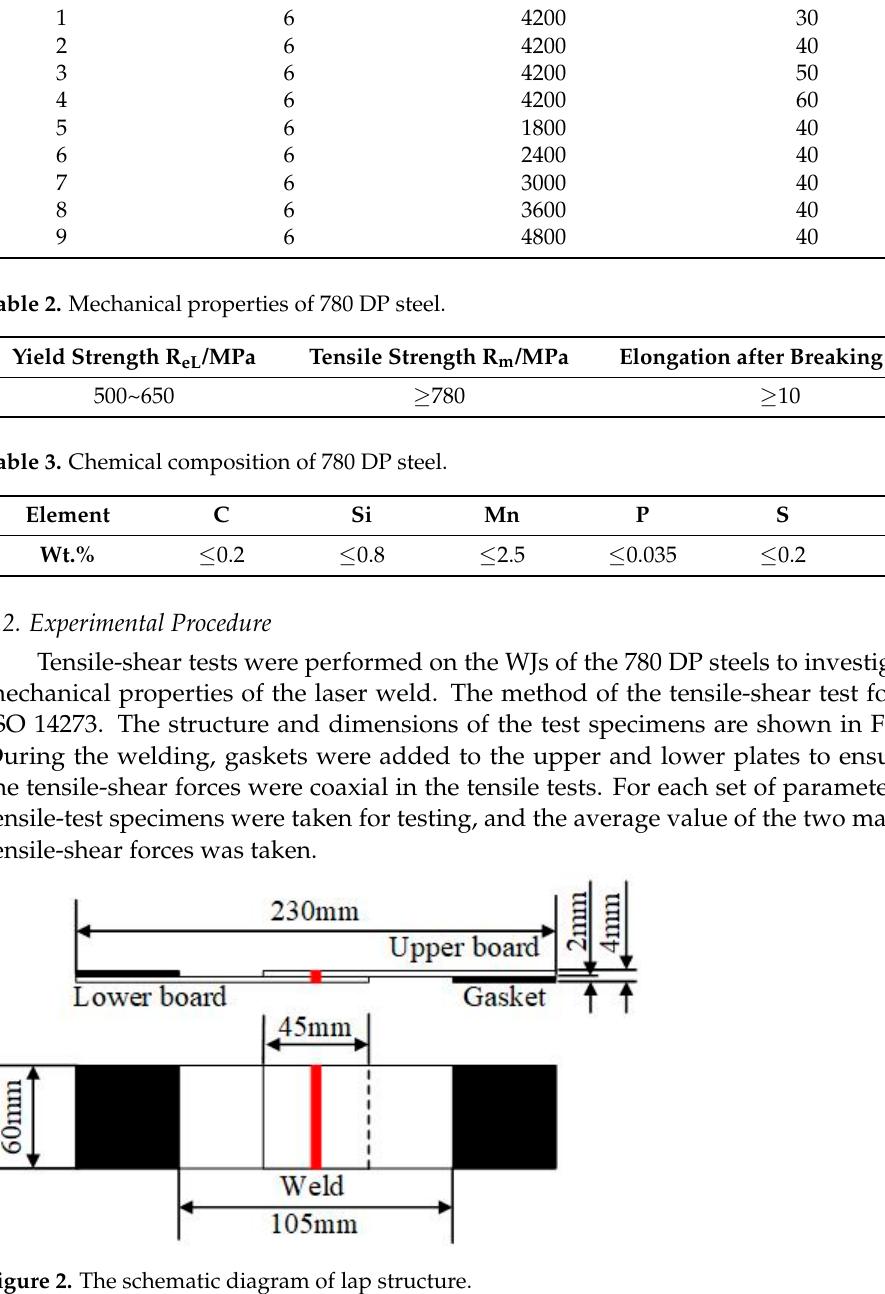
Figure 2. The schematic diagram of lap